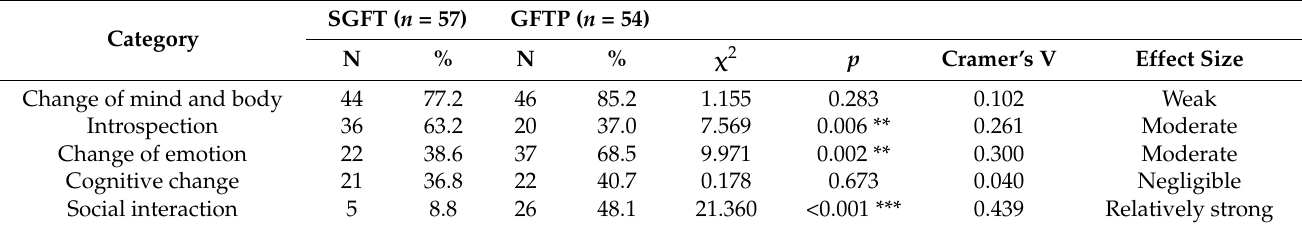
Table 4. Written response category and frequencies on health benefits by type of forest therapy